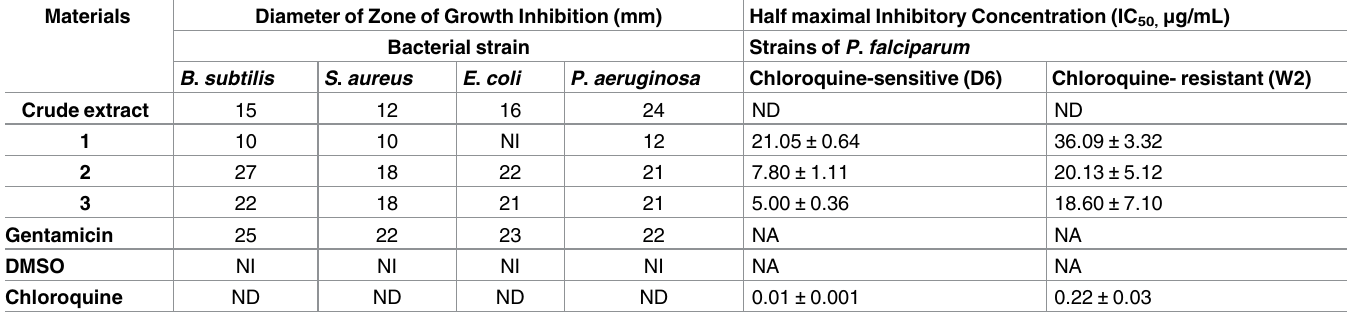
Table 2. In vitro antibacterial and antiplasmodial activities of compounds isolated from A . pulcherrima . Materials Diameter of Zone of Growth Inhibition